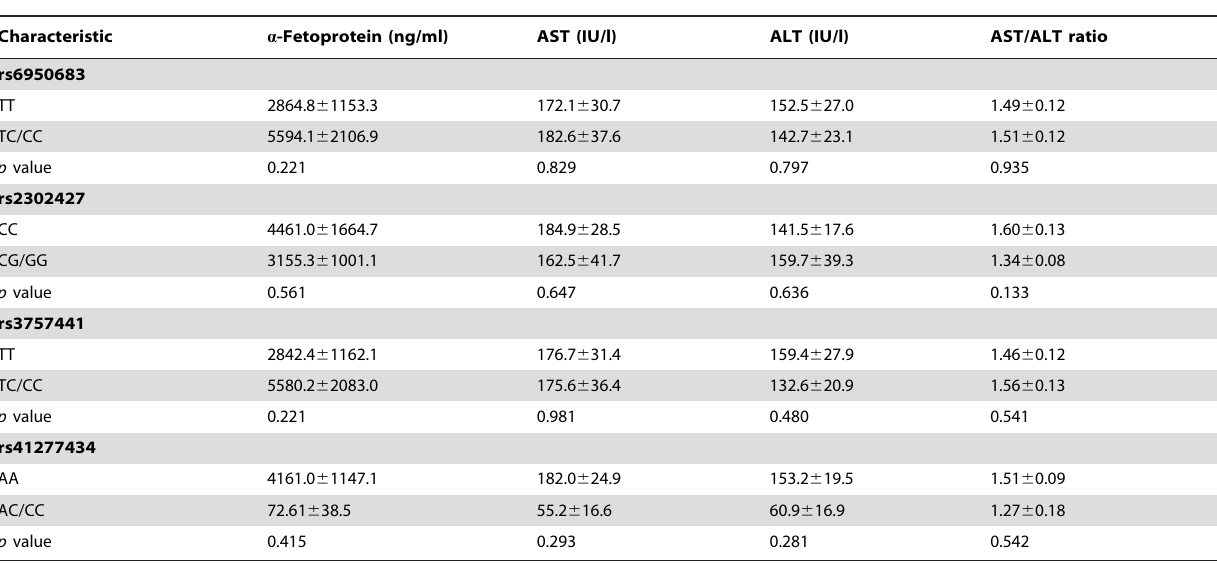
Table 5. Association of EZH2 genotypic frequencies with HCC blood biochemistry